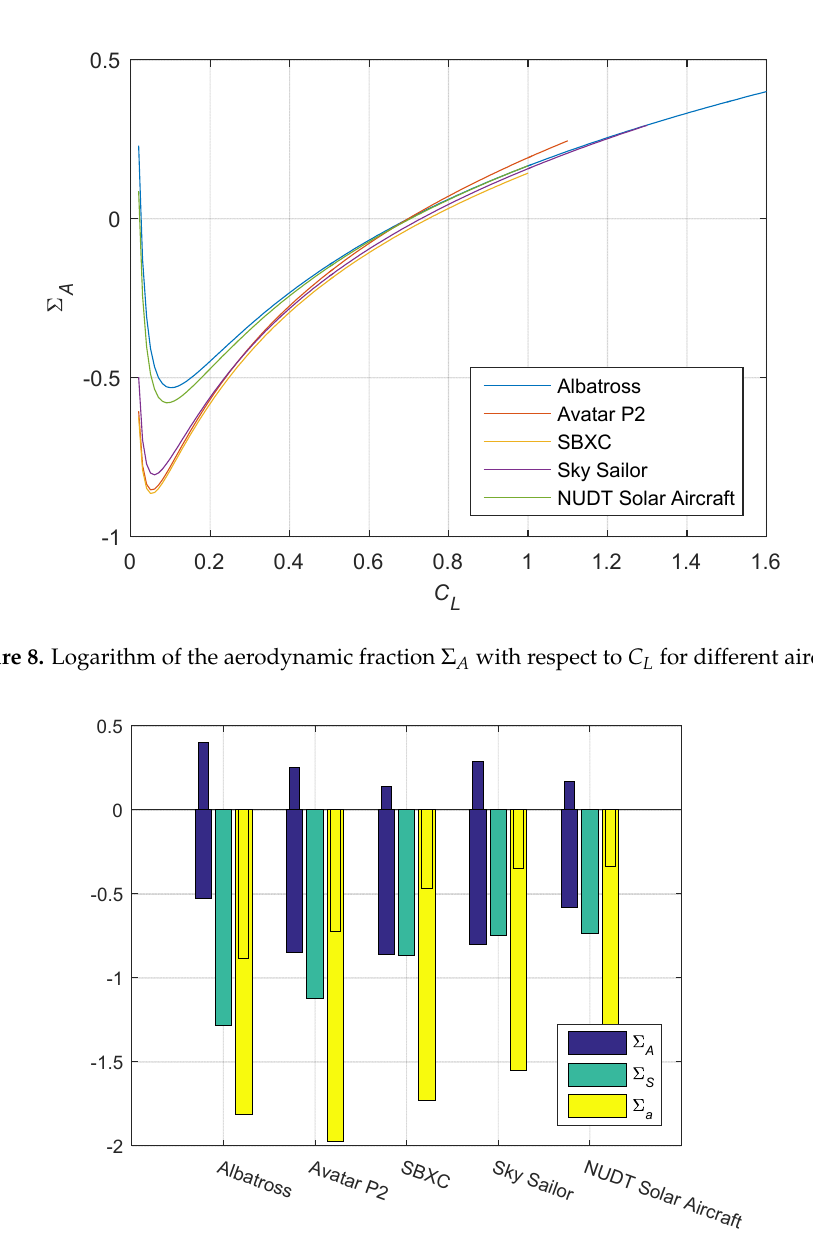
Figure 9. Σ A , Σ S , and Σ a for different aircrafts (the wide and narrow bars respectively indicate the maximum and minimum values).